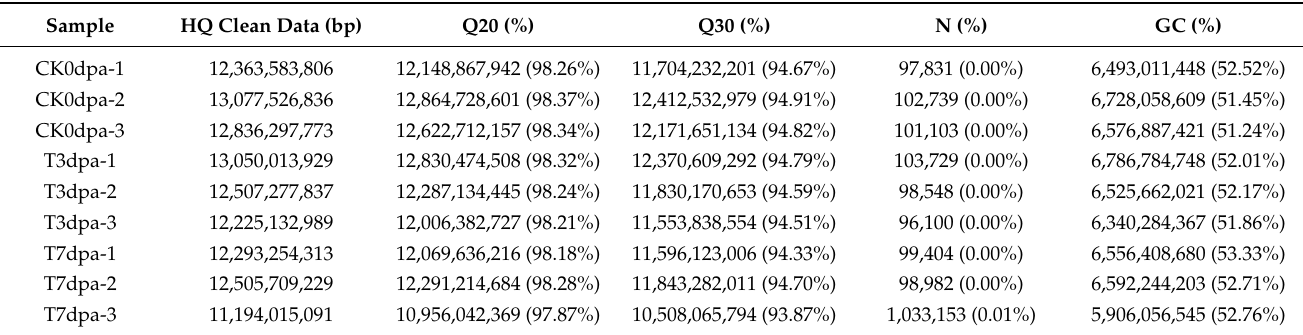
Figure 1. Schematic diagram of the experimental process. ( A ) Schematic diagram of the time points of the zebrafish caudal fin sampling. ( B ) Schematic diagram of the experimental process. CK0dpa, control group at 0 days post-amputation; T3dpa and T7dpa, caudal fin regeneration at 3 and 7 days post-amputation, respectively. Table 1. Summary of lncRNA-seq for each sample.